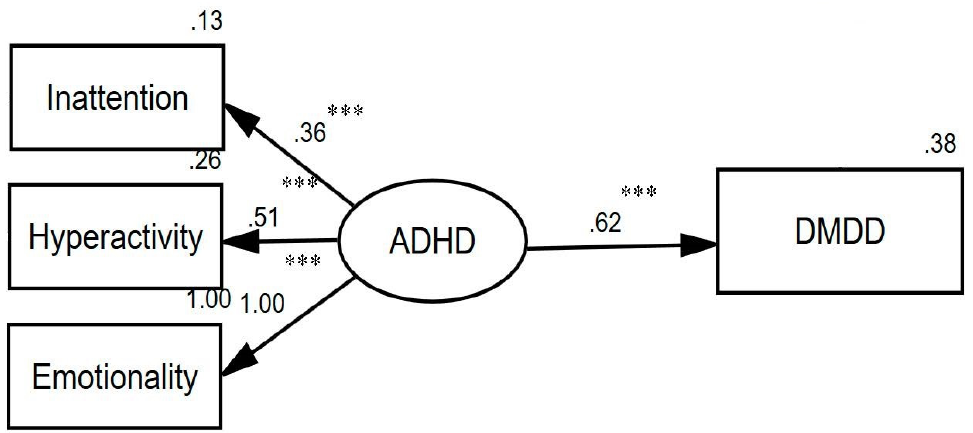
Figure 1. The basic model depicting the direct relationship between ADHD and DMDD. Circles represent unobserved latent variables. Rectangles represent observed measured variables. Values are standardized path coefficients. Goodness-of-fit indicators: Chi-square = 0.322 ( p = 0.571), SRMR = 0.014, RMSEA < 0.001, GFI = 0.998, IFI = 1.006, CFI = 1.000, NFI = 0.997, and TLI = 1.0383. *** p < 0.001. ADHD: attention deficit hyperactivity disorder; DMDD: disruptive mood dysregulation disorder; SRMR = standardized root-mean-square-residual; RMSEA = root-mean-squared error of approximation; GFI: goodness of fit; IFI: incremental fit index; CFI = comparative fit index; NFI: normed fit index; TLI = Tucker–Lewis index.